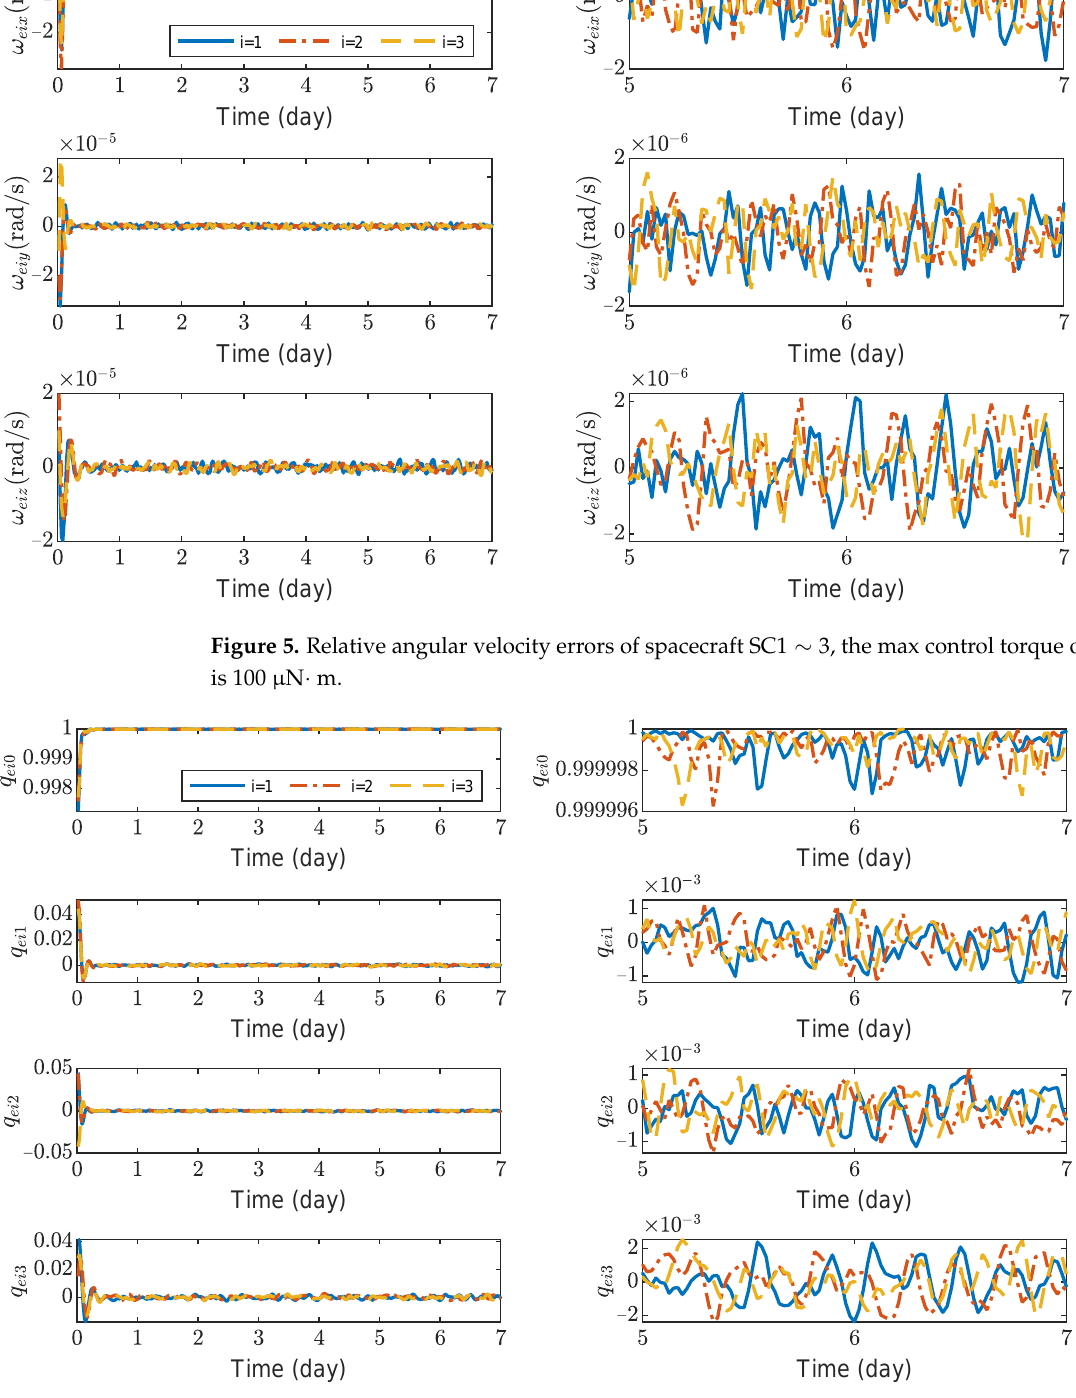
Figure 6. Relative attitude errors of spacecraft SC1 ∼ 3, the max control torque of spacecraft is 100 µ N ·